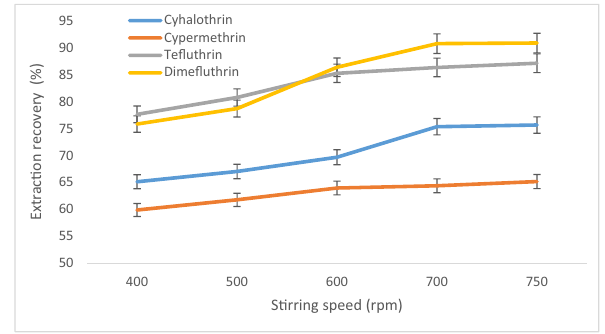
Figure 2: E ff ect of stirring speed on the extraction e ffi ciency ( ex - traction conditions: 100 µL of 100 ng L − 1 of each analyte; extraction time: 180 min; sample volume: 20 mL; temperature: 40°C; pH: 7 ) .